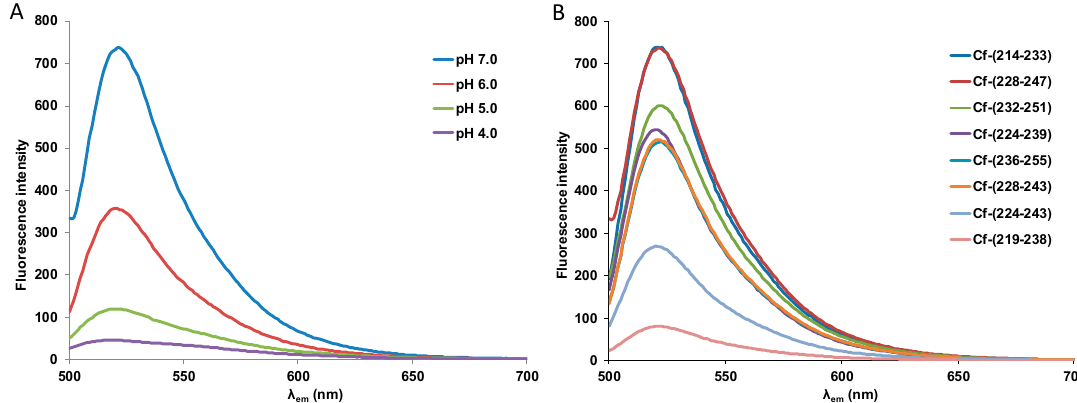
Figure 2. Fluorescence emission spectra of ( A ) peptide Cf-(228–247) at di ff erent pH values and of ( B